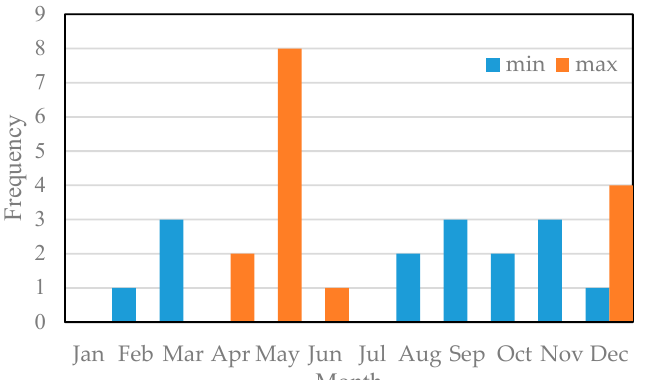
Figure 13. Distribution of the maximum and minimum Δ V s of the lake from 2003 to 2017.